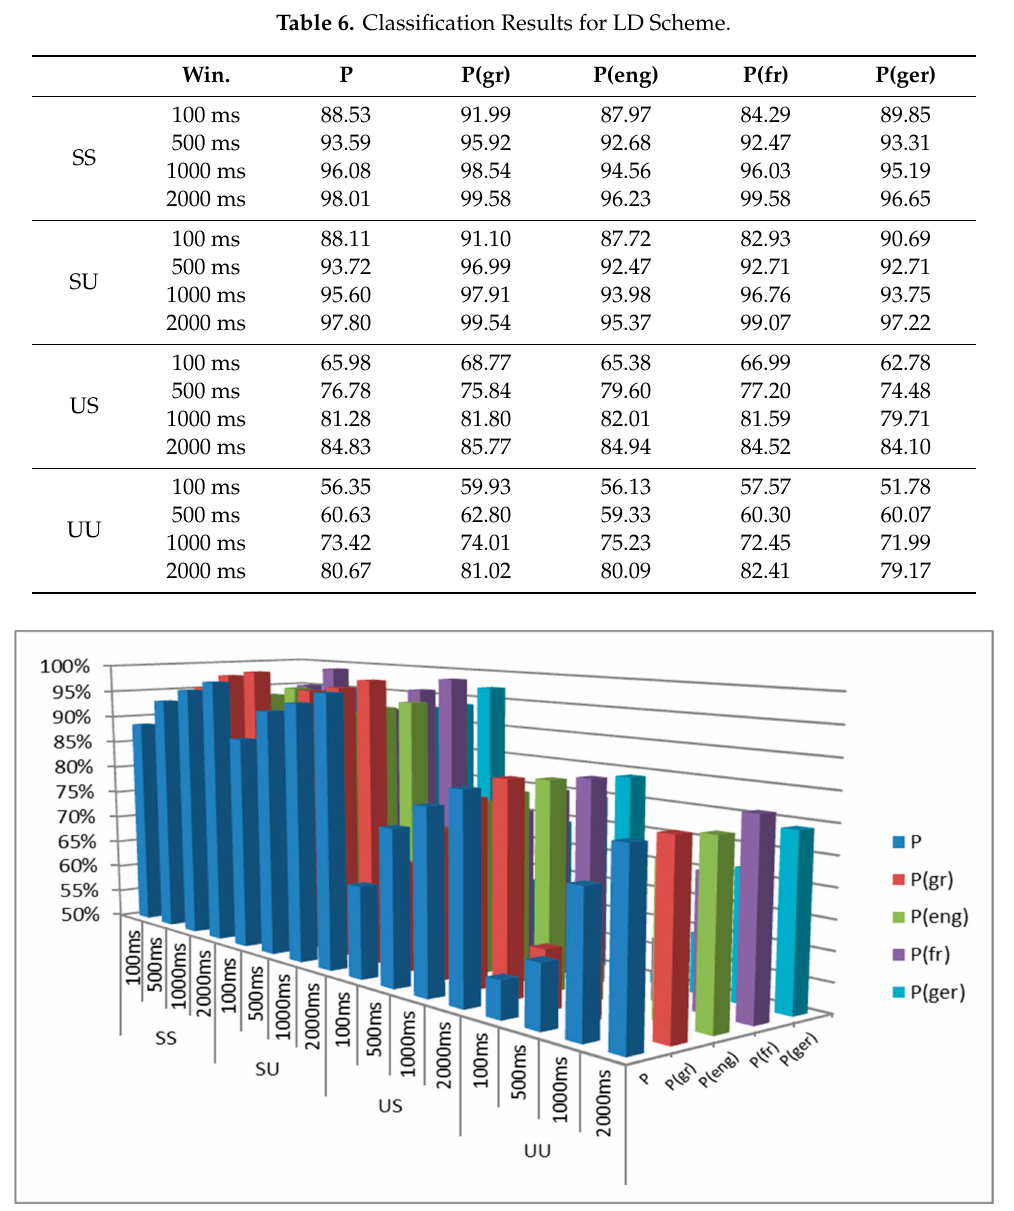
Figure 5. Classification Results for LD